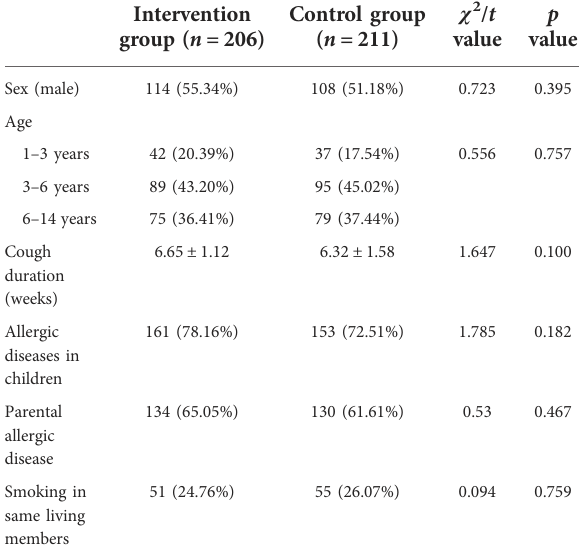
TABLE 3 Comparison of PC-QOL